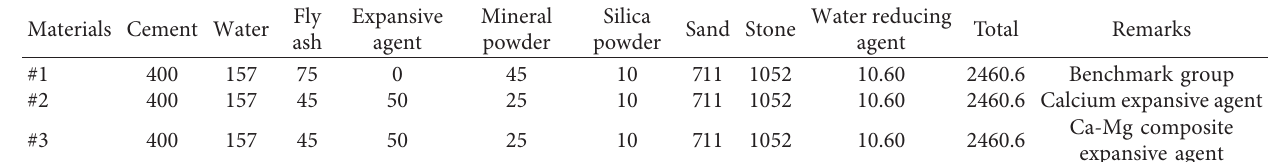
Table 1: C55 concrete test mix ratios (kg/m 3 ).